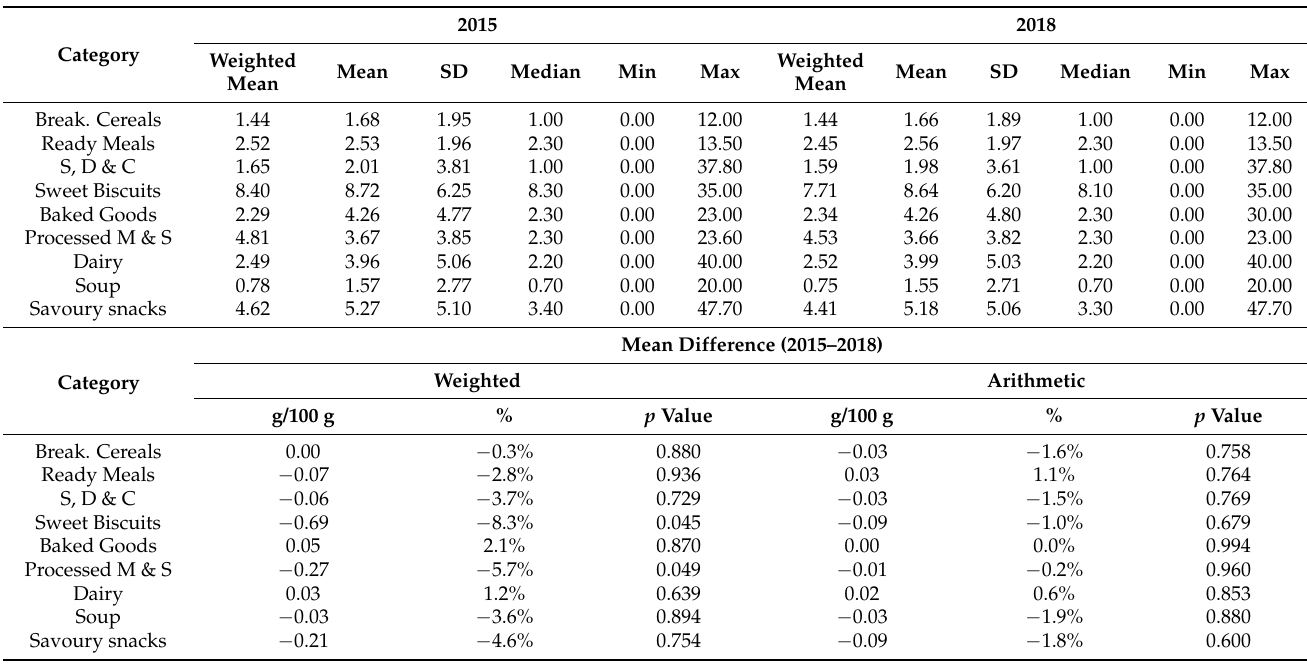
Table 3. Summary statistics and variations of saturated fat content (in g/100 g) for selected packaged food categories in Europe.